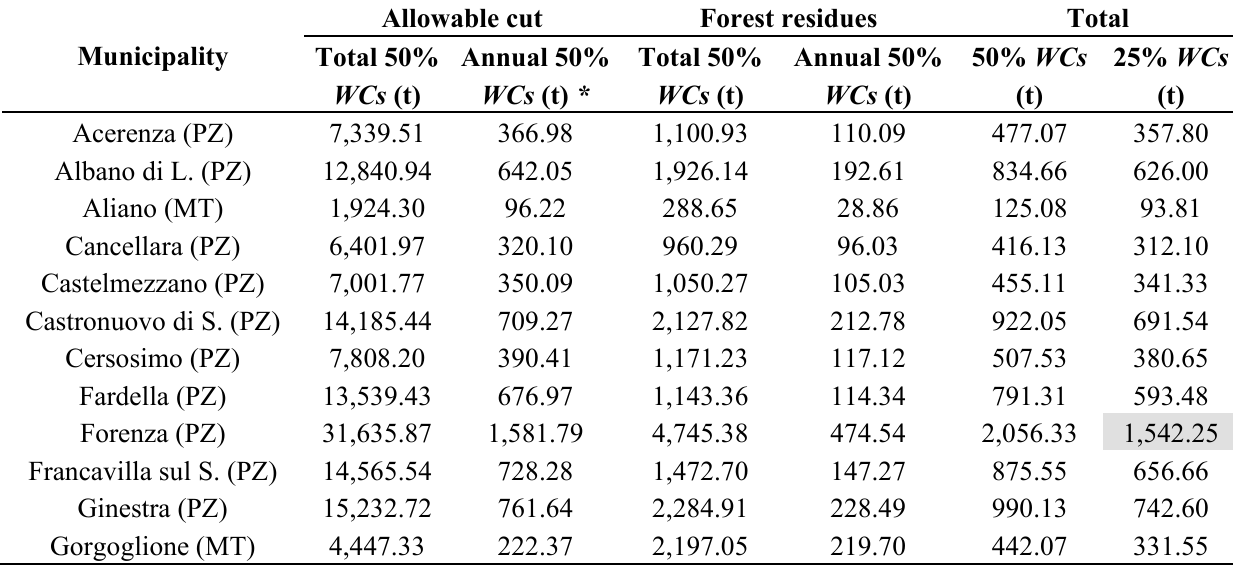
Table 5. Municipal available biomass. Source: Elaboration of the RU. Allowable Municipality